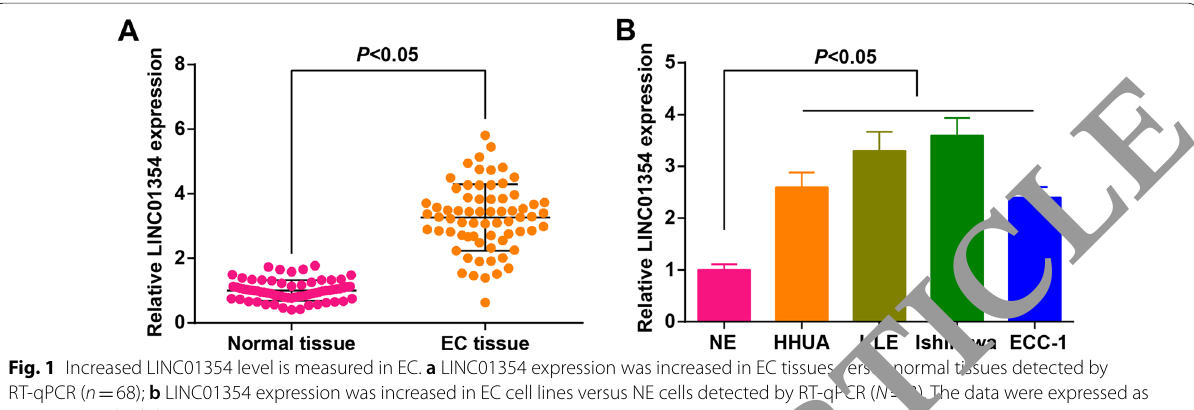
3). The data were expressed as =